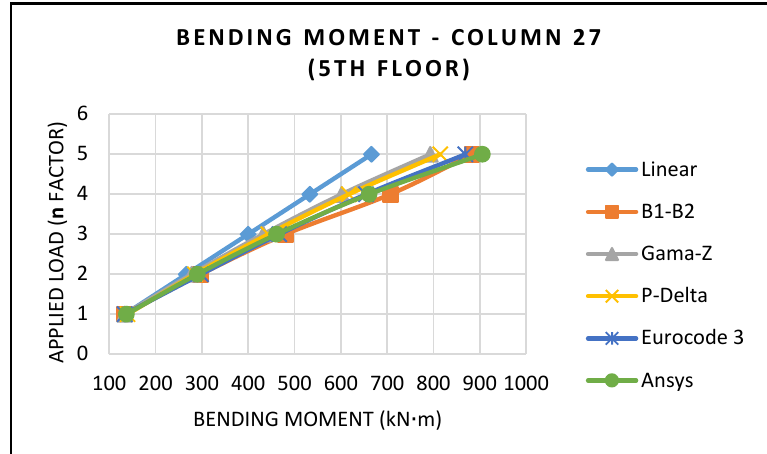
Figure 9 – Load - bending moment relationship for column 27. Source: Authors